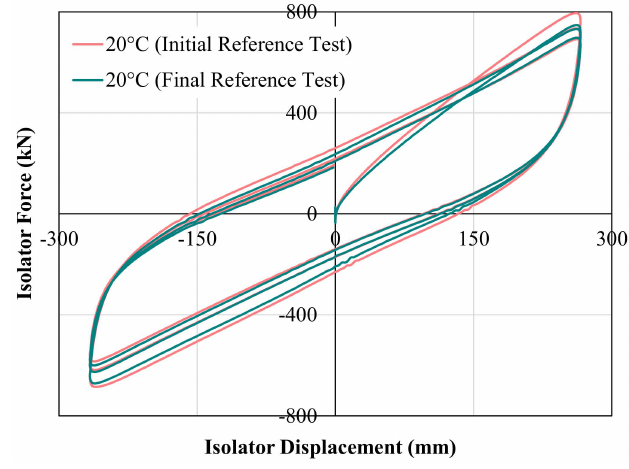
Figure 6. Comparison of reference force-displacement curves of the LRB. Figures 7 and 8 depict force-displacement curves recorded under different loading combinations defined as functions of shear strain, ambient temperature, and exposure time to low temperature. It is clear that both the strength and lateral stiffness of the LRB tend to increase regardless of the loading frequency when the ambient temperature decreases. Another observation is that the hysteretic behavior of the LRB is sensitive to exposure time at low temperatures.